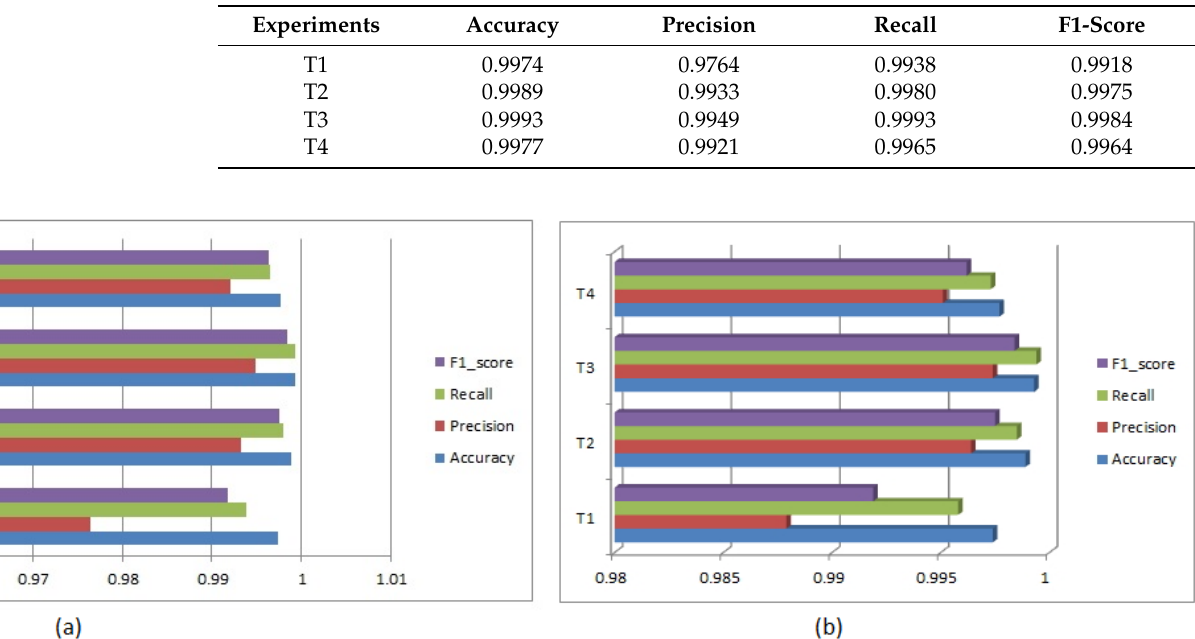
Table 3. A summary of achieved metrics in all the experiments from the confusion matrix. Exp.